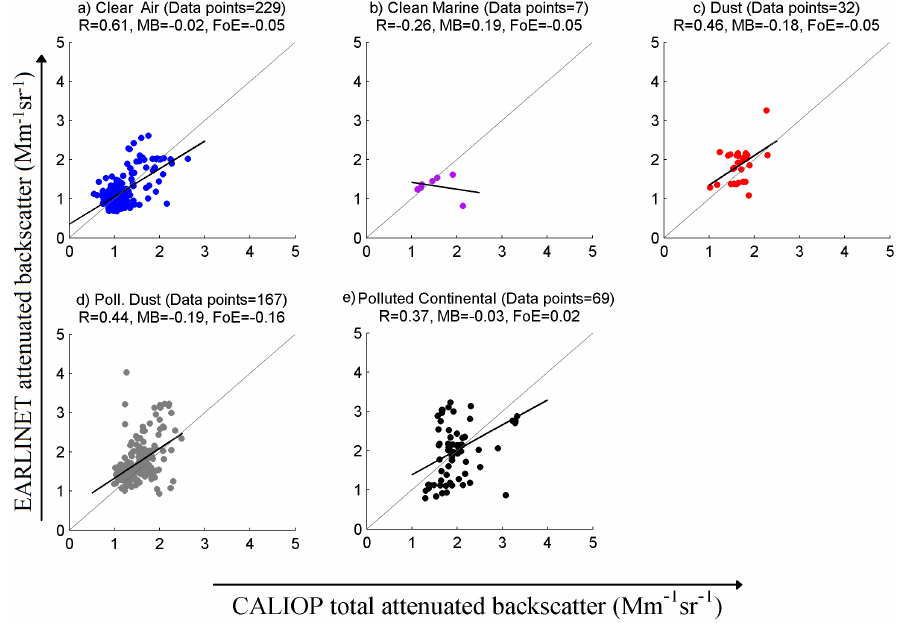
Figure 12. Five Level 1.5 feature types for CALIOP overpasses over EARLINET stations for the PBL. The plot includes filtered data points for overpasses without layers present in both the PBL and the FT.